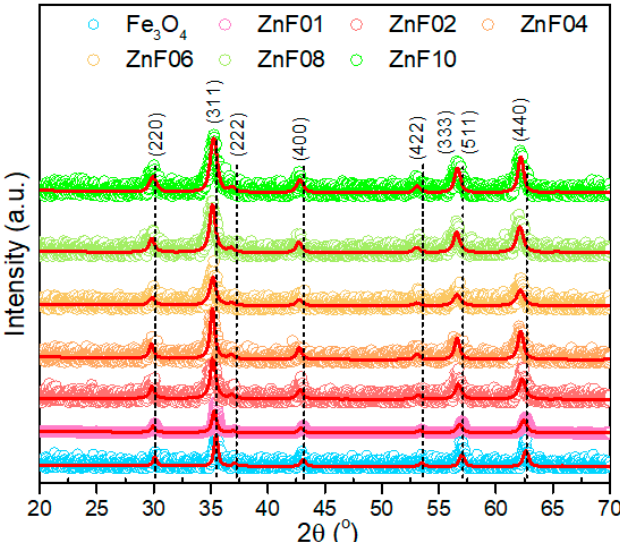
Figure 2. XRD diffraction patterns of Fe 3 O 4 and ZnF particles. The dashed black lines indicate the progressive shift of all diffraction peaks towards lower angles. The diffractograms were shifted for clarity.